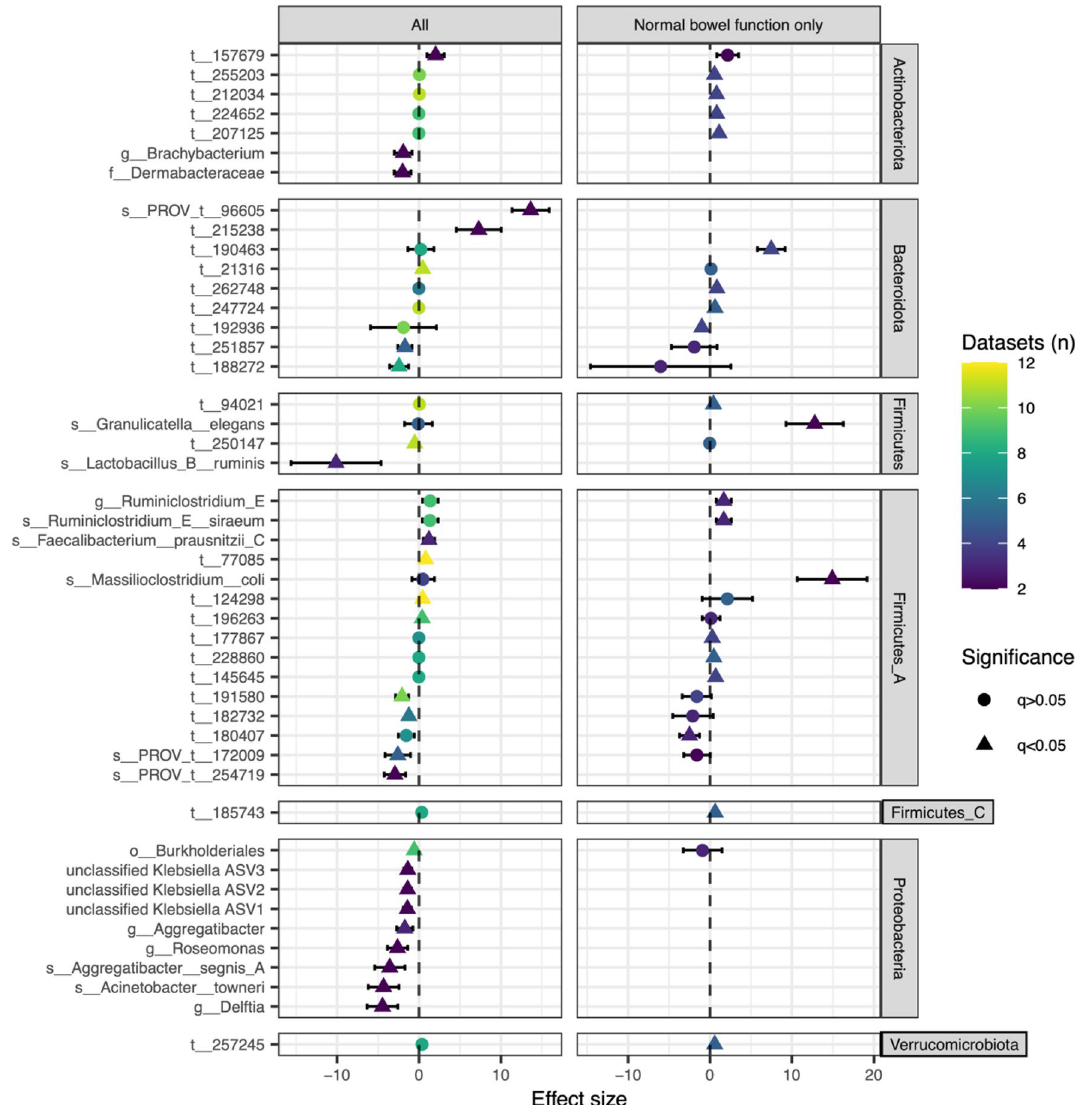
Figure 4. Bowel dysfunction confounds relationships linking ASD to differential bacterial taxa abundances. Taxa significantly associated with NT (positive direction) or ASD (negative direction) by meta-analysis are plotted by phylum. Taxonomic label prefixes indicate the taxon’s rank where t__, s__, g__ or f__ are strain, species, genus or family, respectively. ASD-associated signatures are different when children with bowel dysfunction are included (left panels) compared to when only children with normal bowel function are considered (right panels). Missing data points indicate taxa absent from the remaining datasets and individuals. Effect sizes and significance were calculated using random-effects